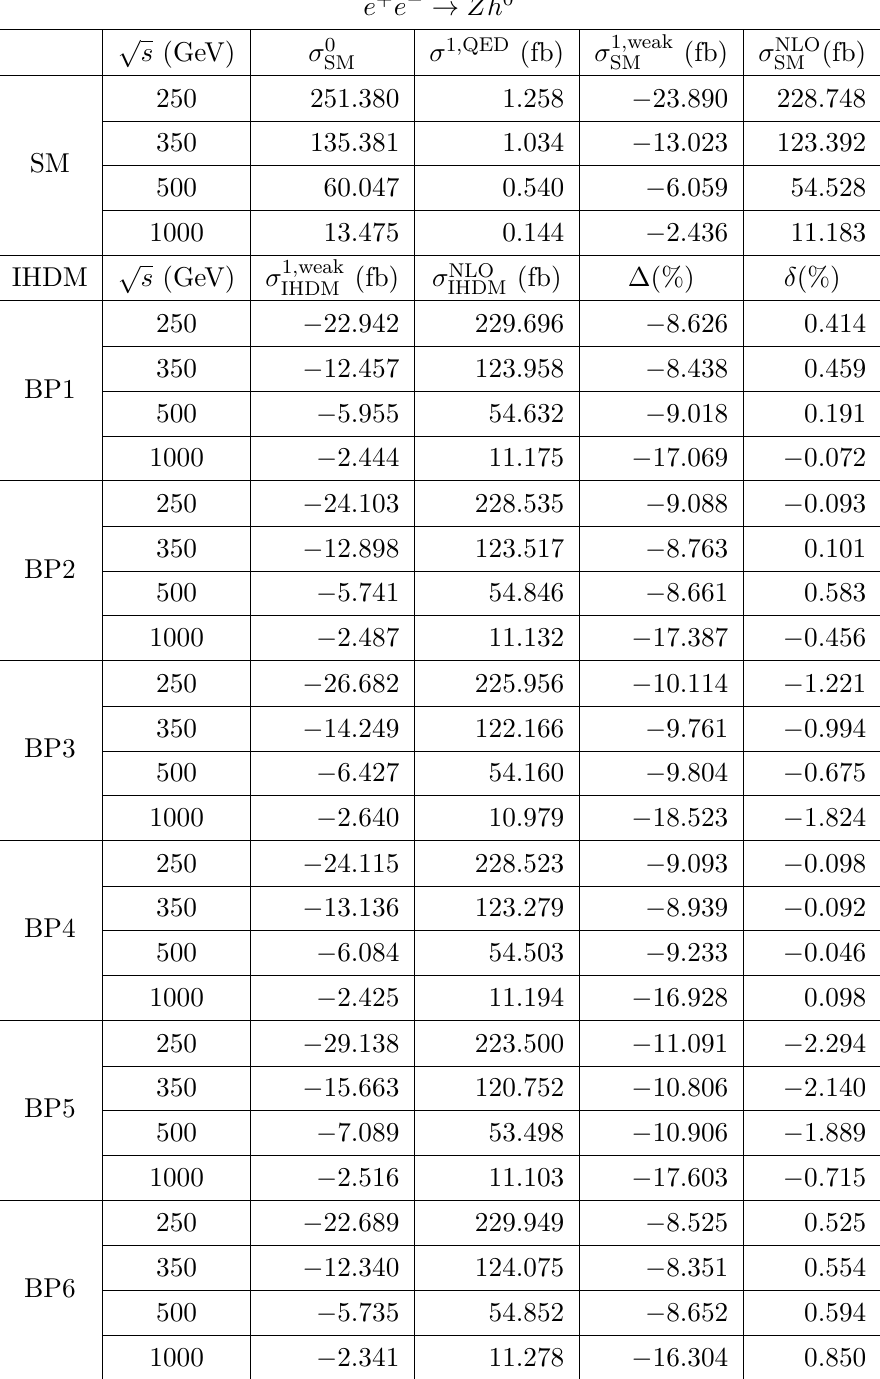
Table 5 . Total cross section for e + e − → Zh 0 for different CM energy. The IHDM parameters are fixed according to table